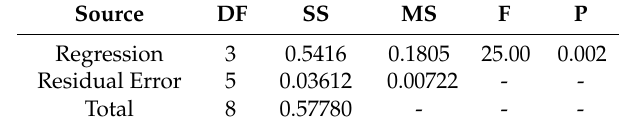
Table 14. Analysis of variance.